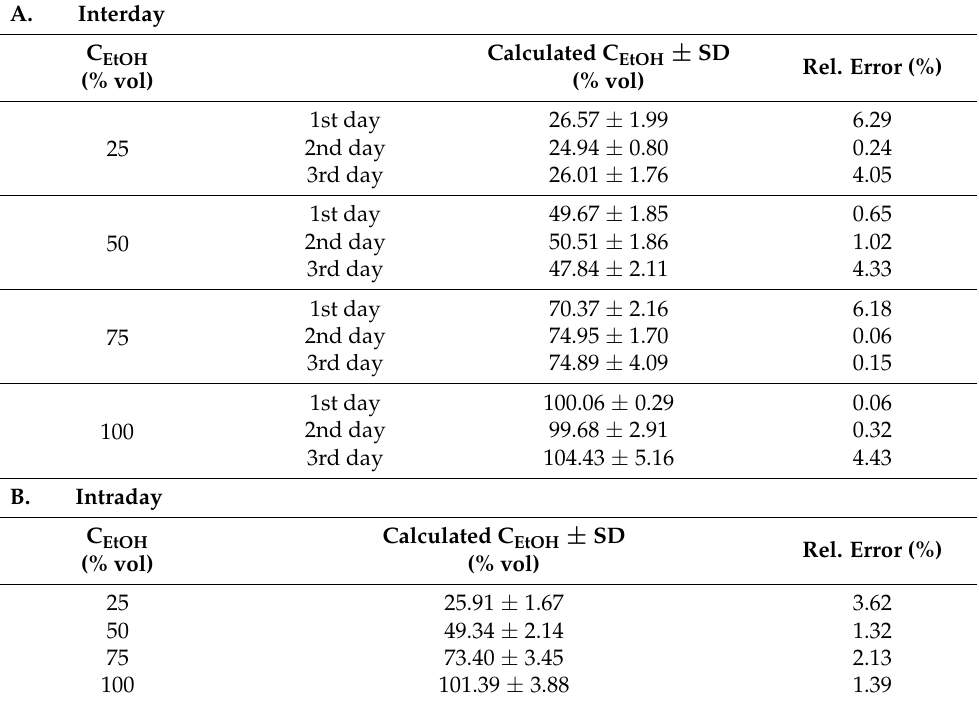
Table 3. Interday (A) and intraday (B) repeatability tests for ethanol–water standard solutions. A.